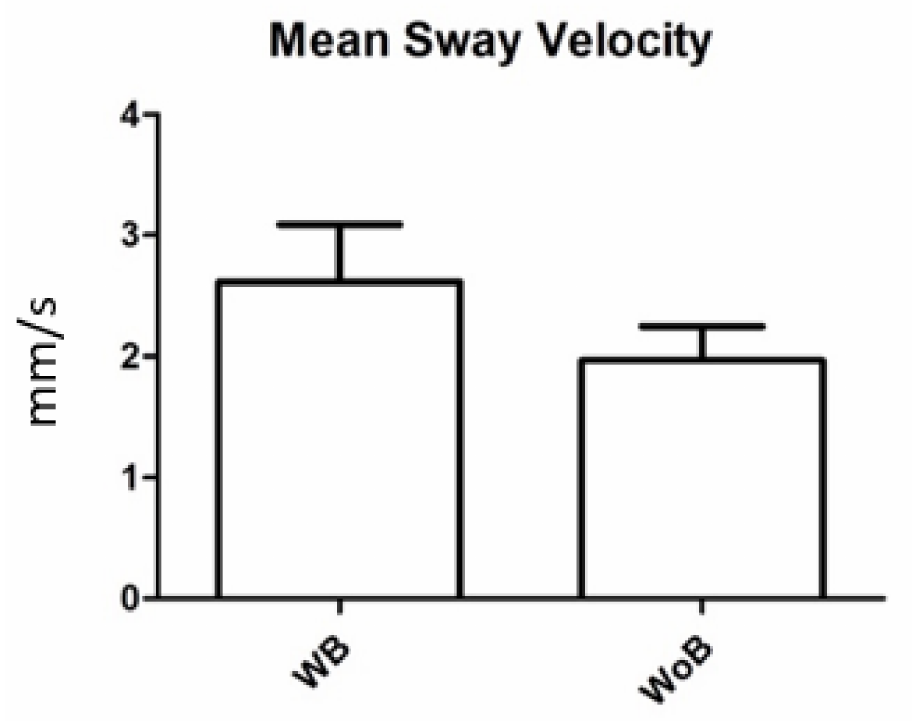
Figure 4. Mean sway velocity (mm/s) in the baropodometric measurement with (WB) and without (WoB) a brace. Error bars represent Standard Error